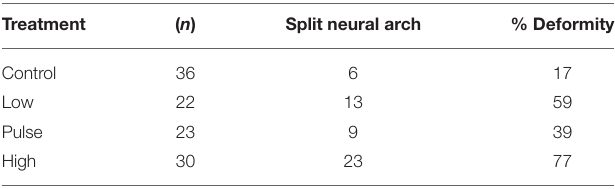
TABLE 2 | Incidence of split neural arches in 44 dph Atlantic haddock fry following crude oil exposure. Treatment